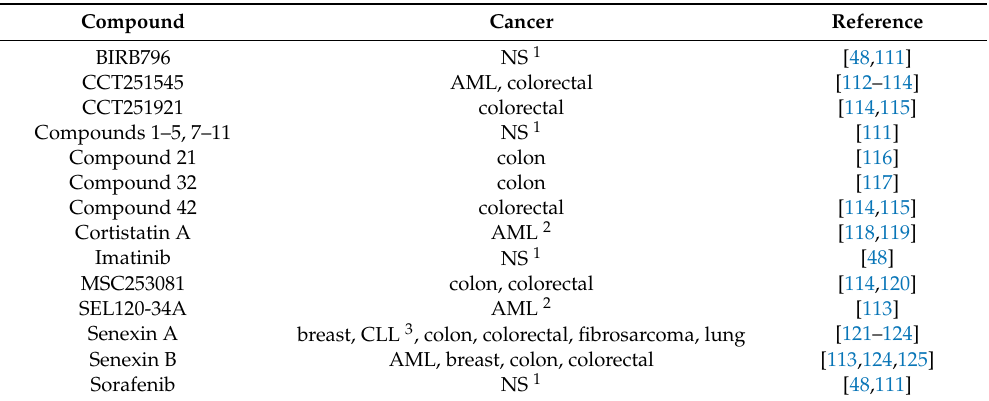
Table 2. Examples of Cdk8 inhibitors with reported anti-cancer